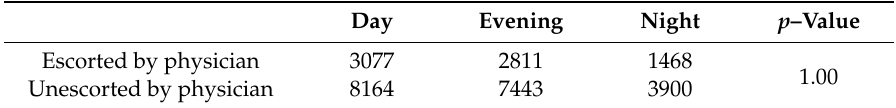
Table 2. Modes of admission of patients transported to hospital with and without physician escort according to daytime shift, evening shift, and night-time